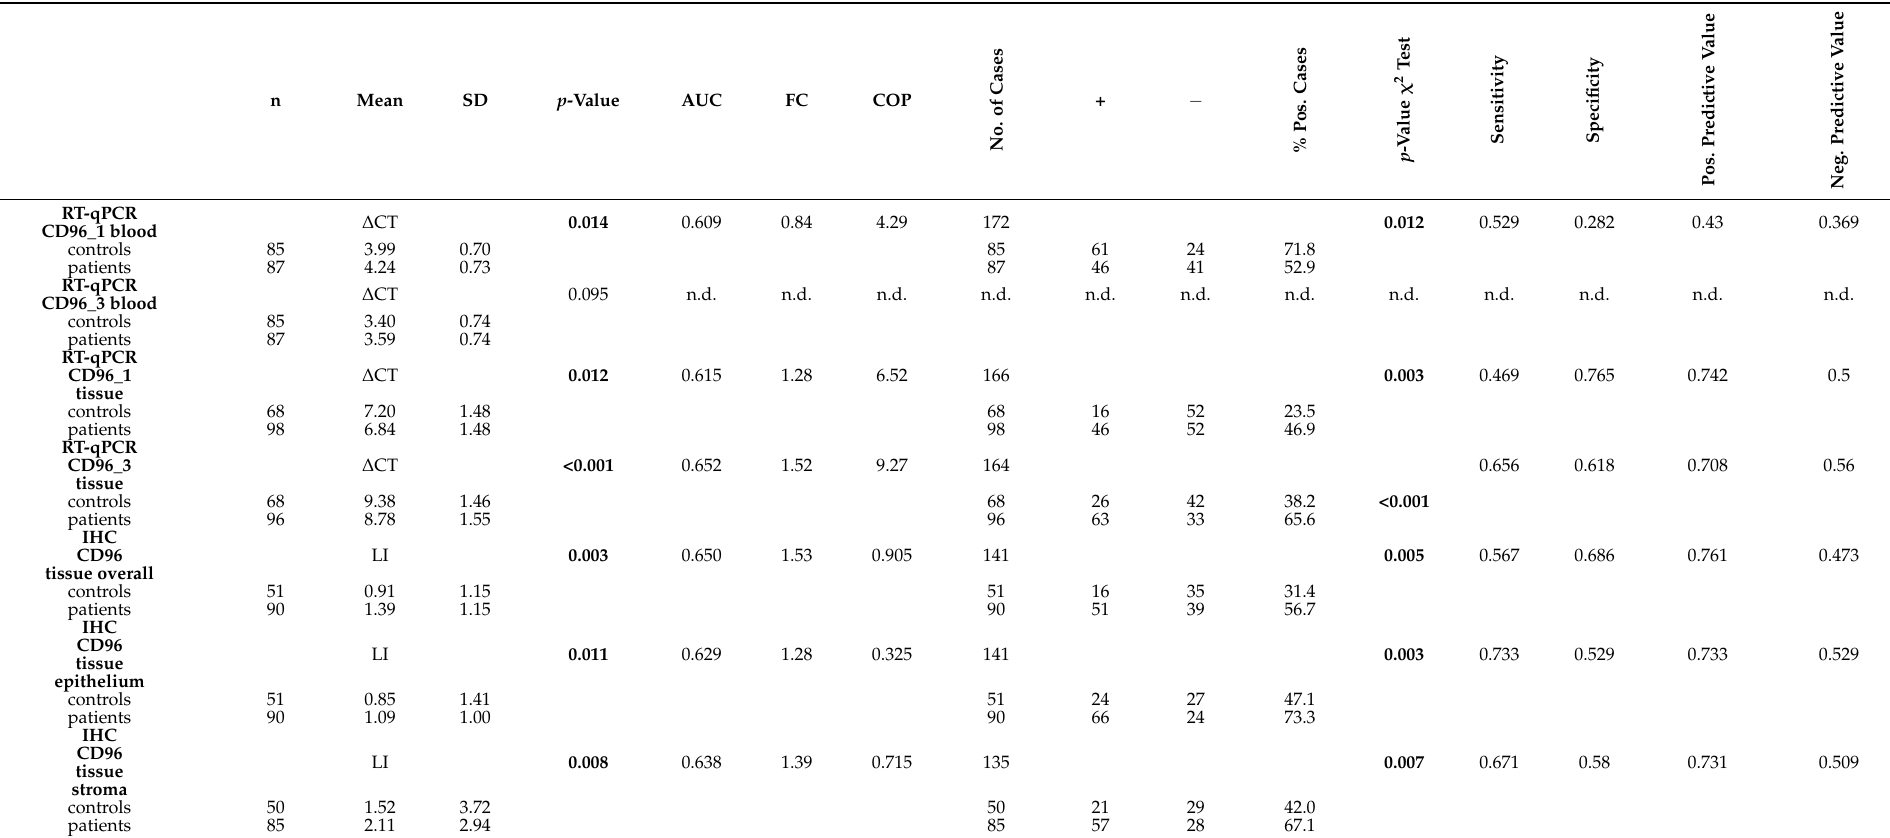
Table 3. CD96 expression in tissue and peripheral blood of healthy controls and OSCC patients. This table compares CD96 expression in peripheral blood and tissue samples, analyzed with RT-qPCR and immunohistochemistry (IHC), between the control and OSCC groups. The mean ∆ CT value (mean) for RT-qPCR and the labelling index (mean) for IHC, standard deviation (SD), and the p-value provided by the Mann–Whitney U test are shown. Higher labelling indices (LI) indicate higher CD96 expression, whereas a high ∆ CT value indicates a lower CD96 expression. Regarding the CD96 expression, the area under the curve (AUC), fold change (FC), and cut-off point (COP) values are given. The controls and patients were labelled as positive and negative, based on their mean ∆ CT value or labelling index regarding the calculated COP value. Furthermore, the percentage (% pos. cases) of positive-tested cases in the control and the patient group is shown. n.d.: not